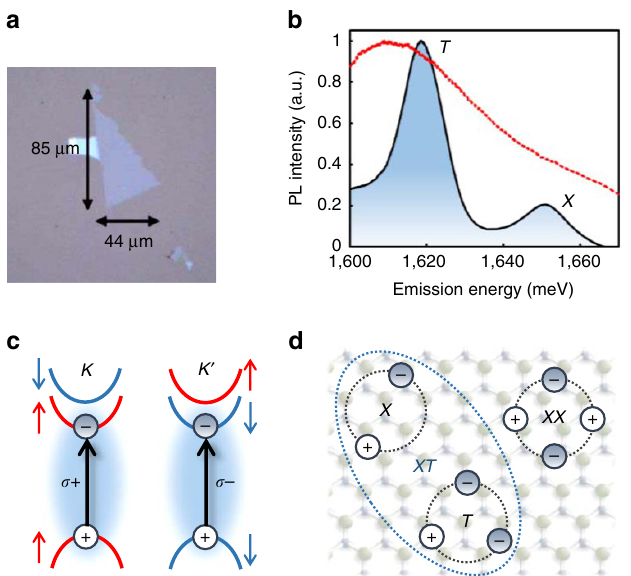
Figure 1 | Excitons, biexcitons and trions in monolayer MoSe 2 . ( a ) Optical microscope image of the monolayer sample. ( b ) Photoluminescence spectrum taken at 13K featuring two peaks near B 1,650 and B 1,620meV attributed to the exciton ( X ) and trion ( T ), respectively. The excitation laser spectrum for the nonlinear spectroscopy experiments is indicated by the dashed red curve. ( c ) Lowest-energy direct-gap transitions at the K and K 0 valleys associated with A -excitons are accessible using s þ and s (cid:2) circularly polarized light, respectively. The valence band associated with the B -exciton is omitted for clarity. ( d ) Illustration of an exciton ( X ), trion ( T ), neutral biexciton ( XX ) and charged biexciton ( XT ) in monolayer MoSe 2